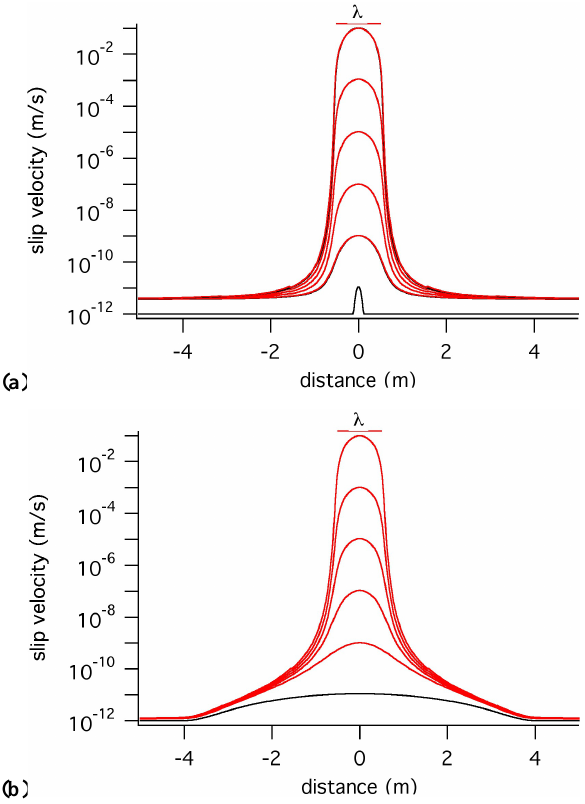
Fig. 6. Rupture initiation using slip and slip rate dependent fault strength (5a) and (5c) and the Barnes-Hut scheme with φ =0.5 on a plane strain fault grid of 40m length and periodic boundary condi- tions. In these calculations f 0 =0.7 a =0.008, b =0.012, d c =1µm, σ n =6MPa τ =0, G =2.1 × 10 4 MPa, and ν =0.25. (a) Initial slip rate (black) is uniform at V s =1 × 10 − 12 m/s outside a centered per- turbation of 0.25m width. The form of the perturbation is one half of 0.5m wave length cosine function of peak to peak amplitude 10 · V start . Different curves show increasing slip velocity within the patch with time. The solution without the Barnes-Hut approxima- tion is also shown but differences between it and BH are not really visible at this scale. Shown for reference is the dominant wave- length as inferred by Dieterich (1992). (b) Same as in (a) except the width of the perturbation (black) is